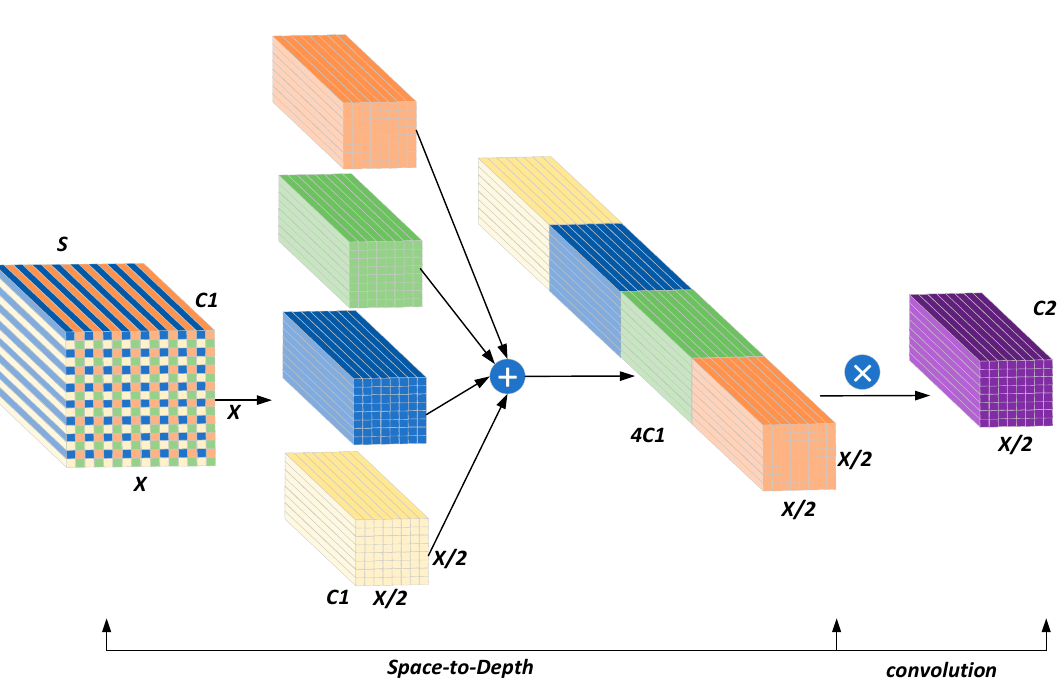
Figure 4. The architecture of space-to-depth (SPD) layer.